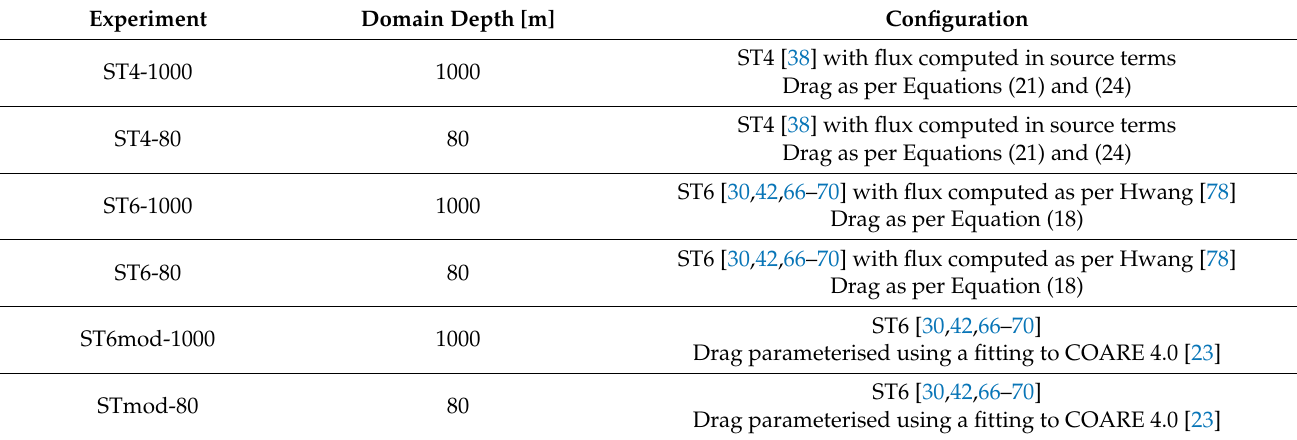
Table 3. Idealised experiments